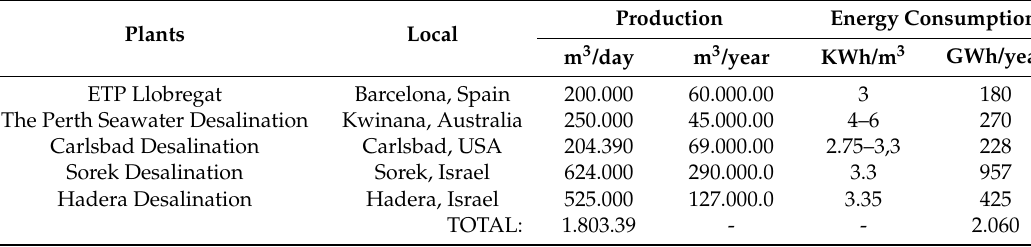
Table 7. SWRO Large-scale desalination